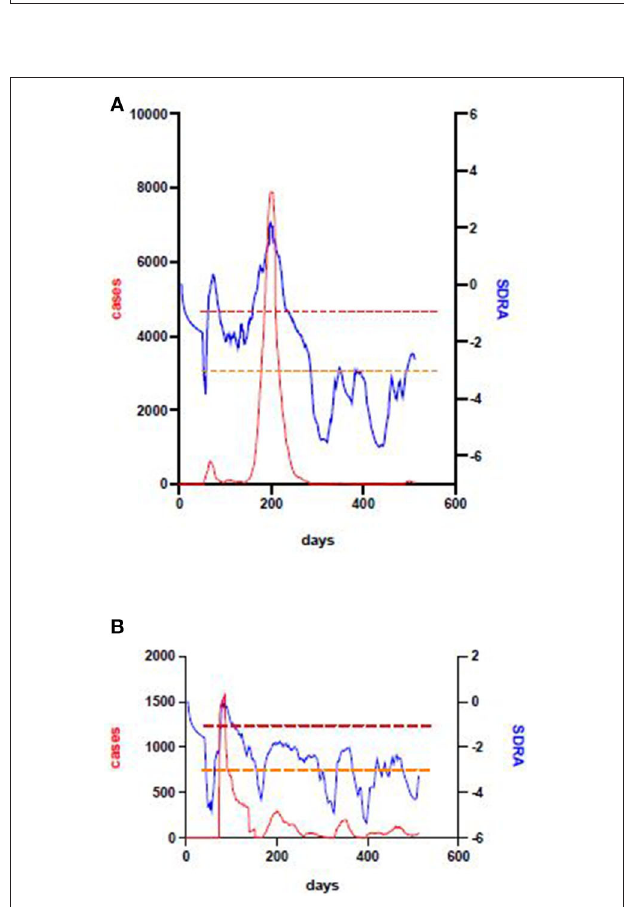
FIGURE 6 | Victoria and New South Wales’ second wave. The large outbreak in Victoria during 2020 was preceded by a failure to sustain a declining CRE after the first pandemic wave, a high and fluctuating SDRA baseline (top). This allowed setting lower (orange) and upper (red) thresholds which indicate the point at which outbreaks may propagate, and the higher point above which they will rapidly get out of control, respectively. Application of the same thresholds to the New South Wales SDRA and case data plot show that the same principle applies, even though the total number of cases is much